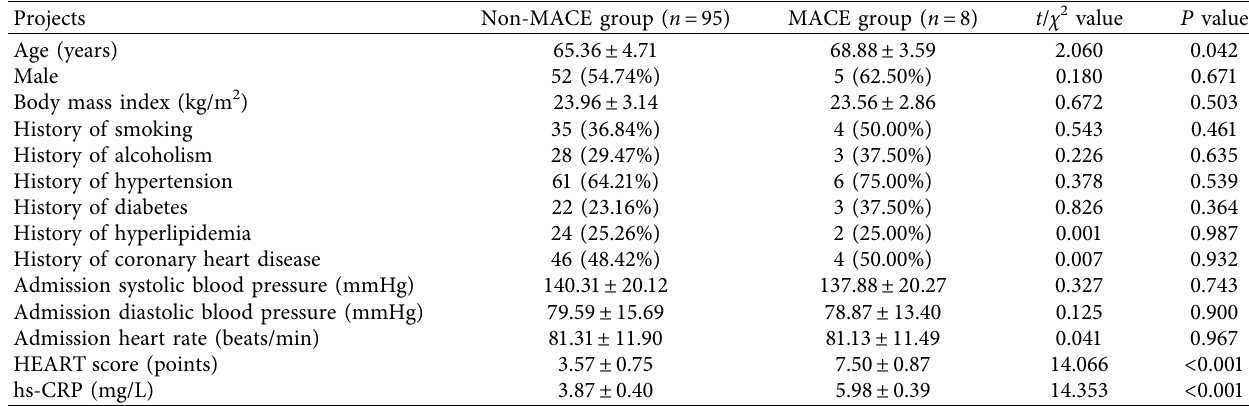
Table 3: Comparison of clinical data between the two groups.